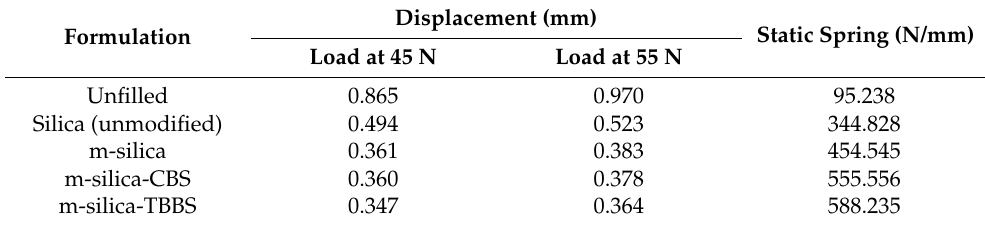
Table 6. The displacement and the static spring of rubber rail